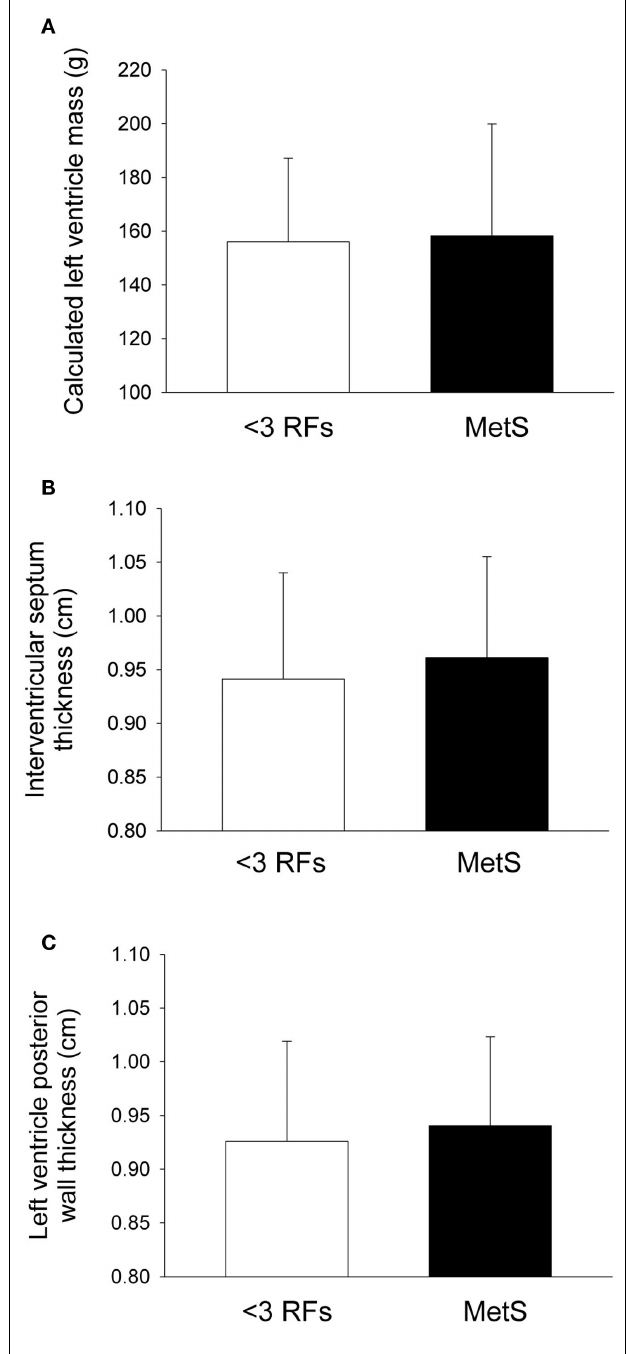
FIGURE 1 | Indices of heart size in individuals with metabolic syndrome (MetS). After adjustment for statin and blood pressure medication use, compared with individuals with less than three risk factors for cardiovscular disease ( < 3 RFs) participants with MetS displayed no differences in (A) left ventricle mass ( P = 0.49), (B) interventricular septal wall thickness ( P = 0.12), or (C) left ventricular posterior wall thickness ( P = 0.17).There were significant effects of anti-hypertension medication use and statin use in all variables (see Tables 4 and 5 ).Values are mean ± SD. Corresponding SE values are (A) 6.0g ( < 3 RFs) and 6.3g (MetS); (B) 0.02cm ( < 3 RFs) and 0.01cm (MetS); (C) 0.02cm ( < 3 RFs) and 0.01cm